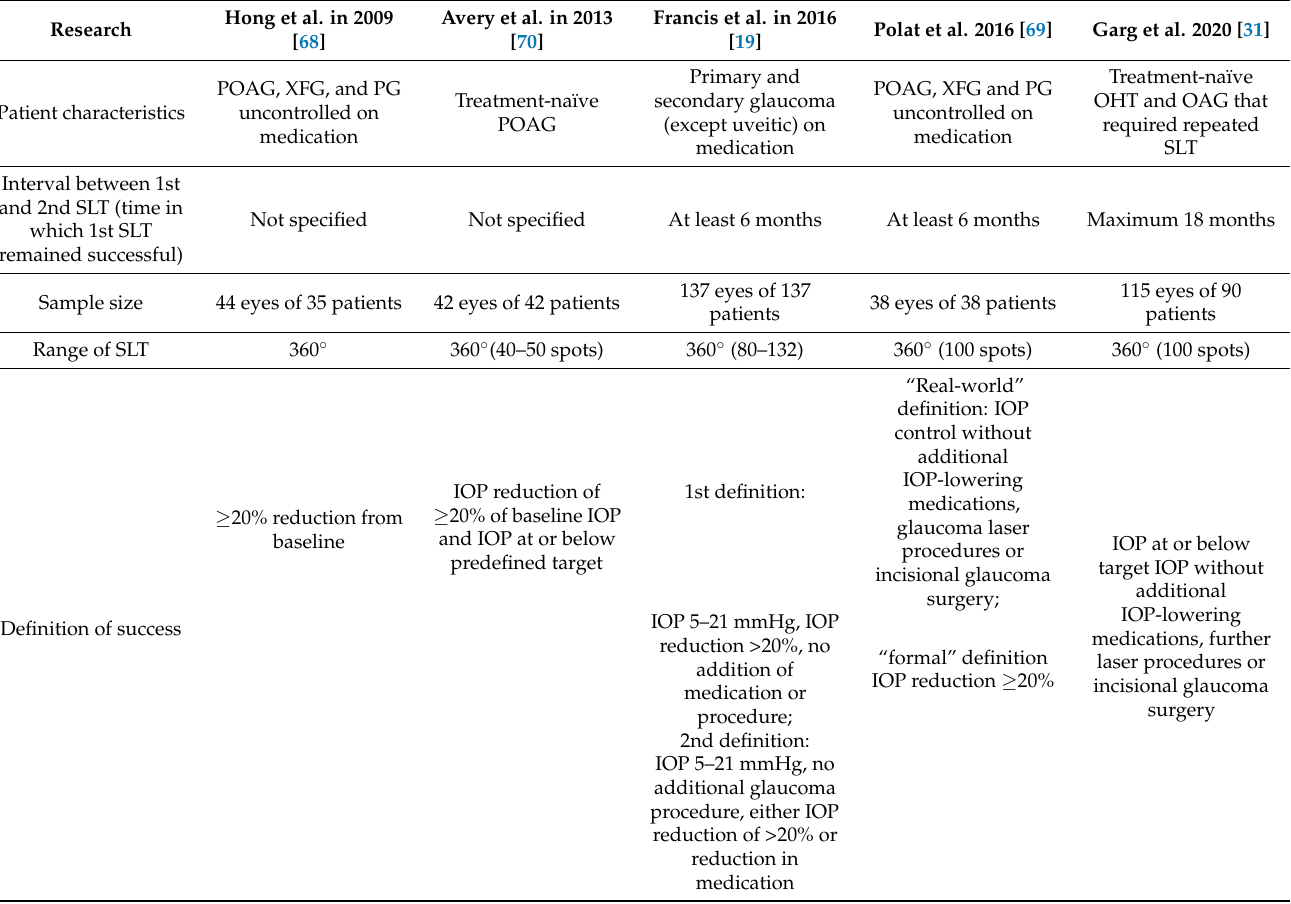
Table 2. Summary of studies evaluating SLT